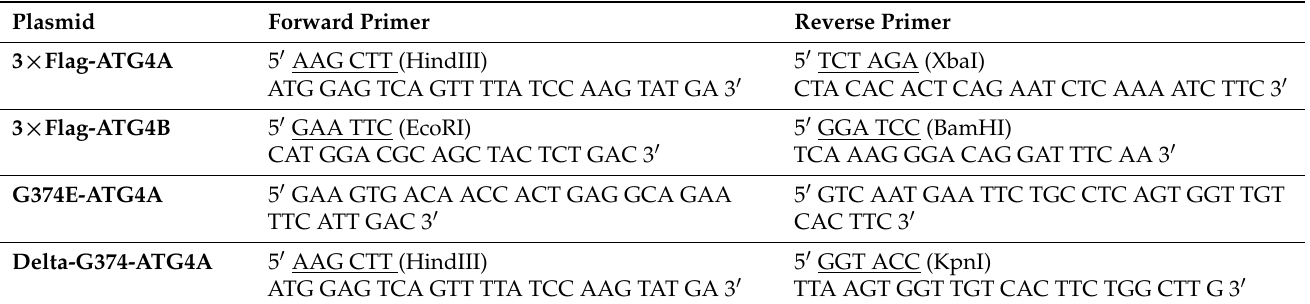
Table 1. Plasmid names and corresponding primer